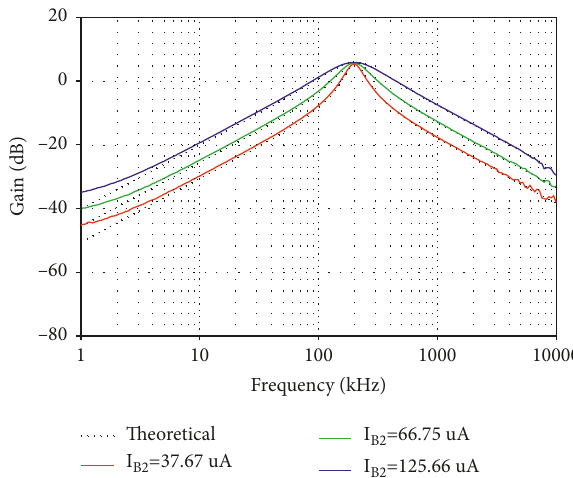
Figure 11: Experimental magnitude frequency response of BP function when I B 2 is